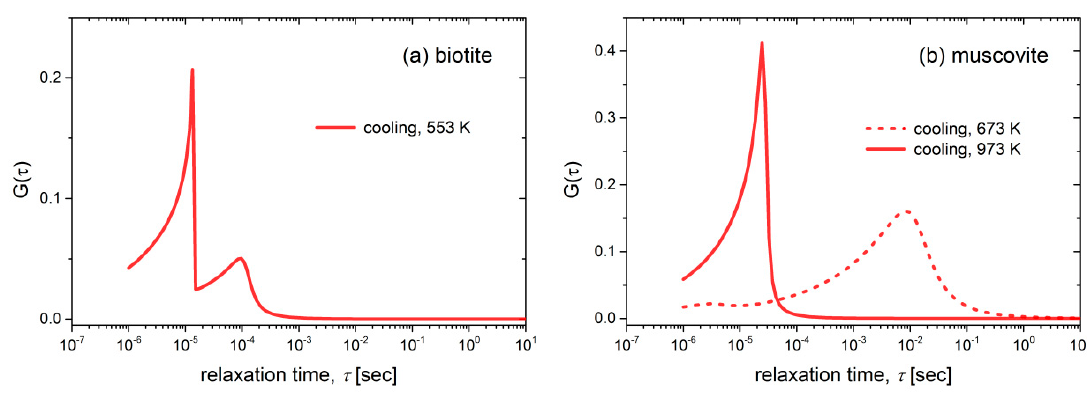
Figure 9. Distributions of the relaxation times G ( τ ) for ( a ) biotite and ( b ) muscovite samples at selected temperatures during their cooling.